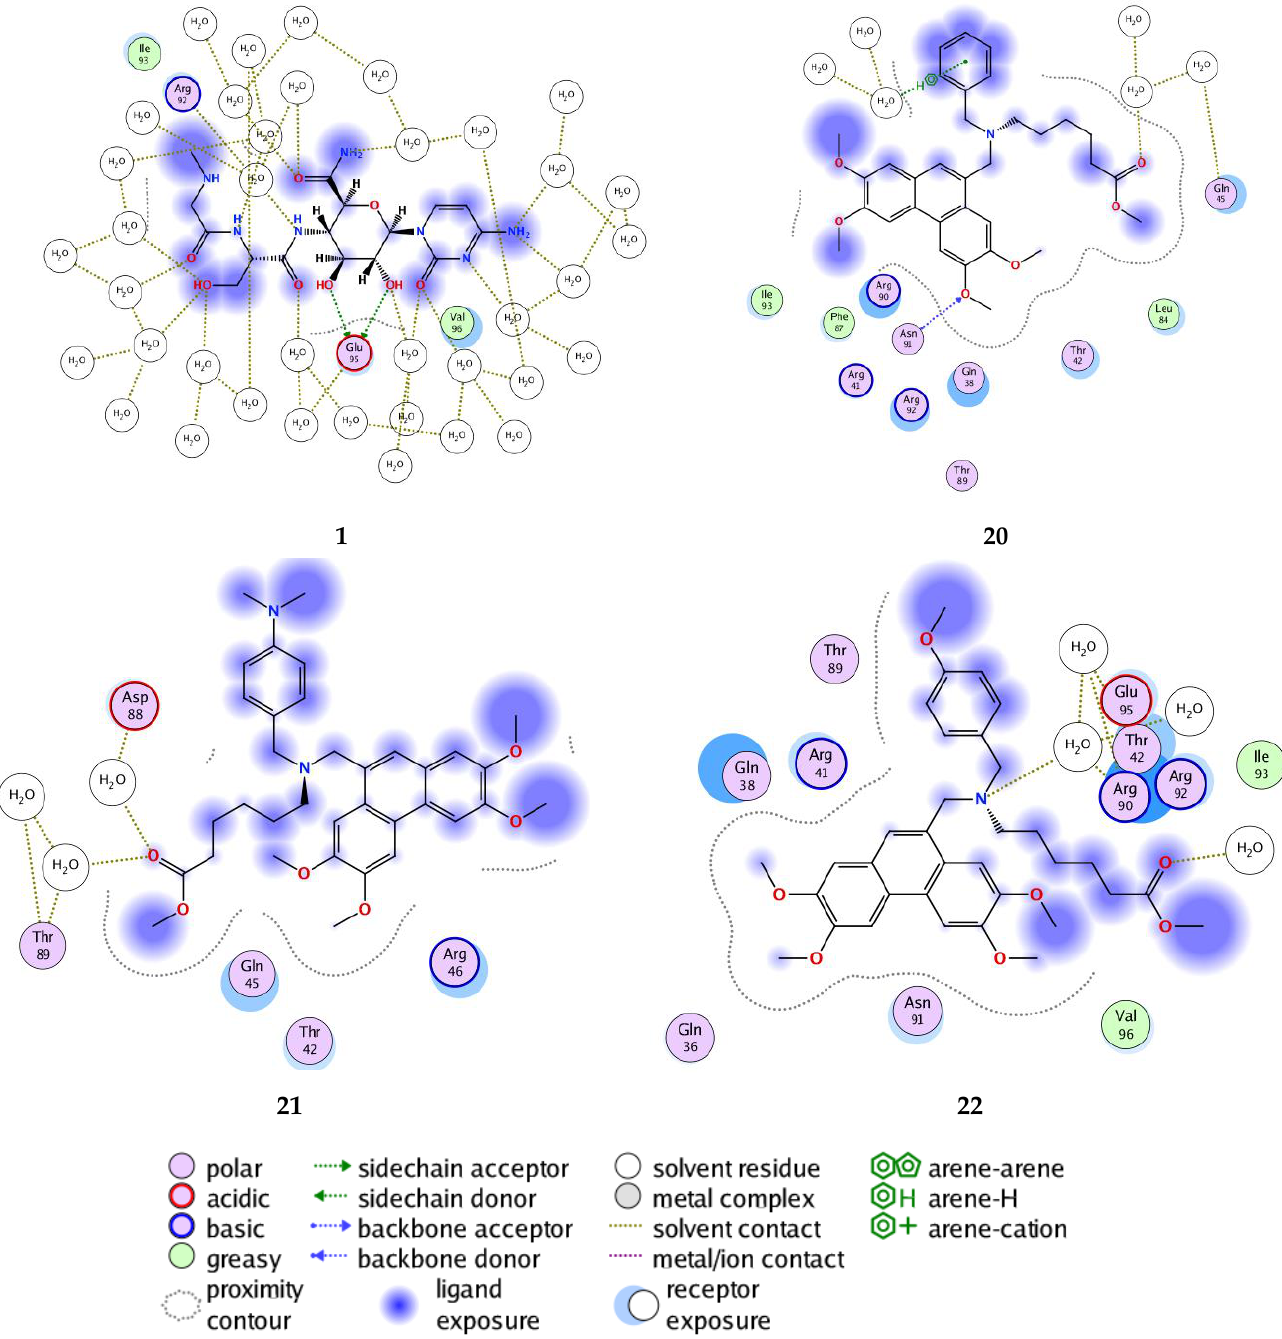
Figure 3. Docked pose and binding affinity of compounds 1 and 20 − 22 .